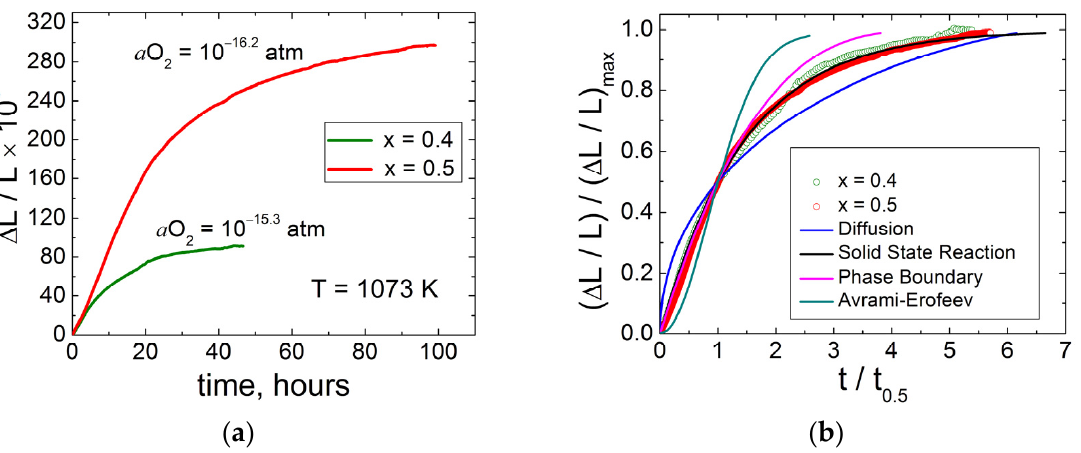
Figure 9. The results of chemical expansion study of oxidation process in CaV 1–x Mo x O 3± δ (x = 0.4 and 0.5) at 1073 K and constant a O 2 value in Δ L/L = f(t) ( a ) and ( Δ L/L) normalized = f(t/t 0.5 ) ( b ) plots.